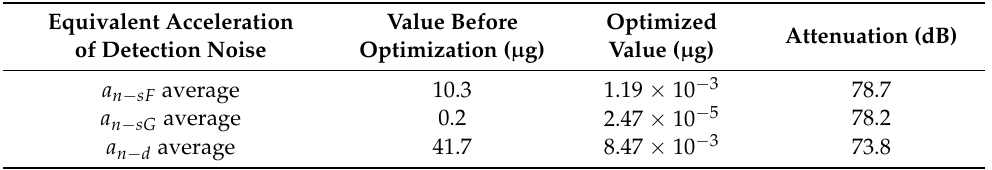
Table 9. The average value of the detection noise equivalent acceleration before and after the optimization of the differential capacitor detection circuit. Equivalent Acceleration of Detection